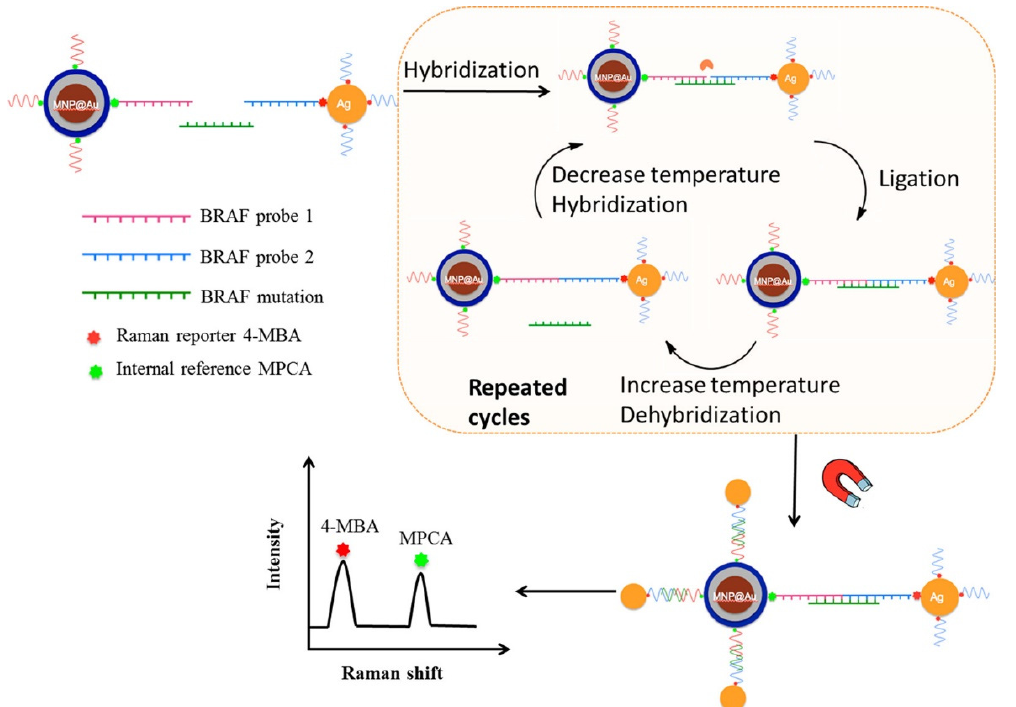
Figure 6. The scheme presenting a SERS method developed by Yu et al. of BRAF mutation detection by using two types of probe plasmonic nanostructures: DNA-covered Fe 3 O 4 @SiO 2 @Au nanoparticles and DNA-covered Ag nanoparticles. Reprinted with permission from [45]. Copyright 2020 American Chemical Society.